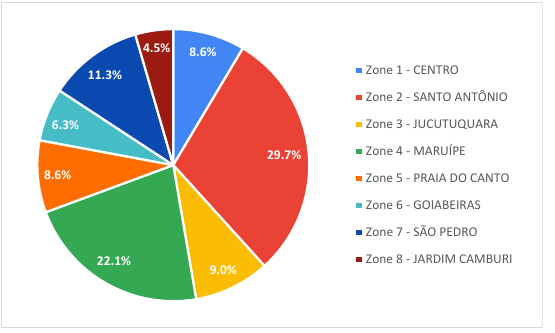
Figure 3. Amount of professional questionnaire answers from each school zone.